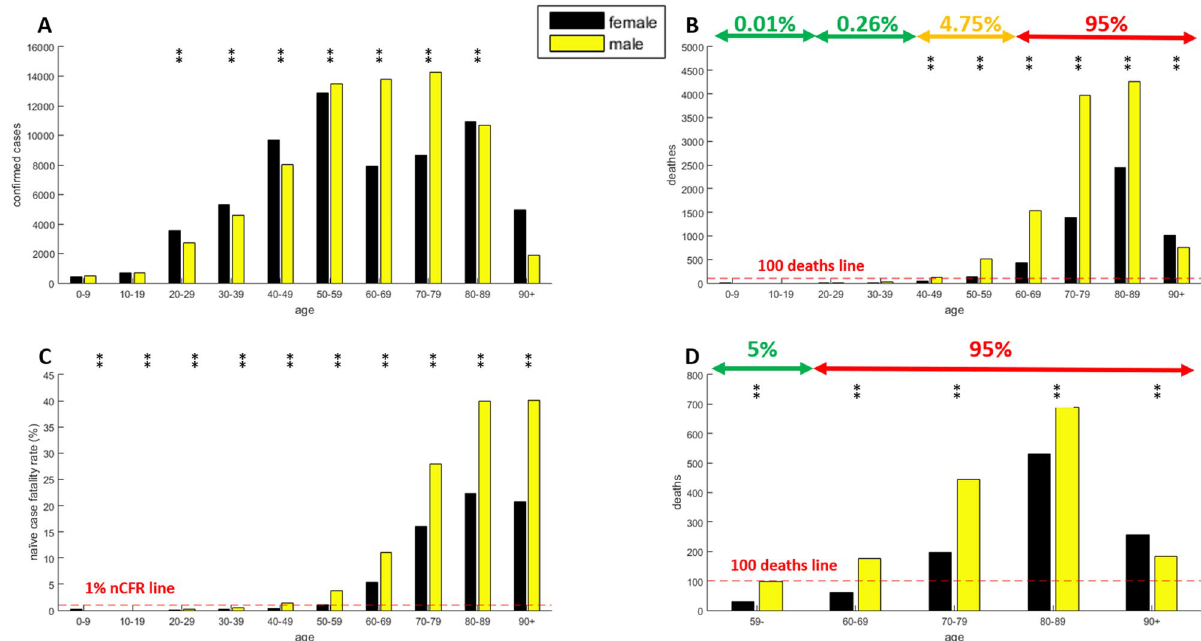
Figure 2. Data analysis of Italy and Germany COVID-19 outbreak on April 2020. (A–C) data of Italian outbreak on April 10, 2020. (A) Confirmed cases, (B) deaths, (C) naïve case fatality rate, (D) deaths data of German outbreak on April 12, 2020. The presence of at least one star (1 star indicates p-values below 0.05, 2 stars p-values below 0.001) on top of a specific age strata indicates that the sex inequality is statistically significant.